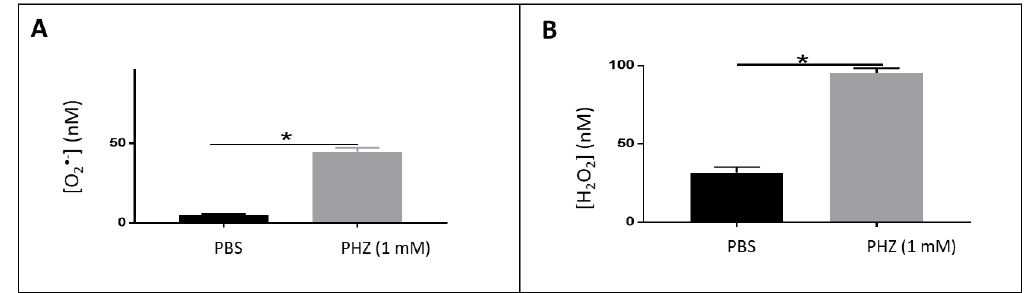
Figure 5. Quantification of superoxide ( A ) and H 2 O 2 ( B ) in PHZ treated RBCs comparatively with untreated ones . Note: results represent six replicates from three independent experiments, value = mean ± SD. * = Significant ( p < 0.05).